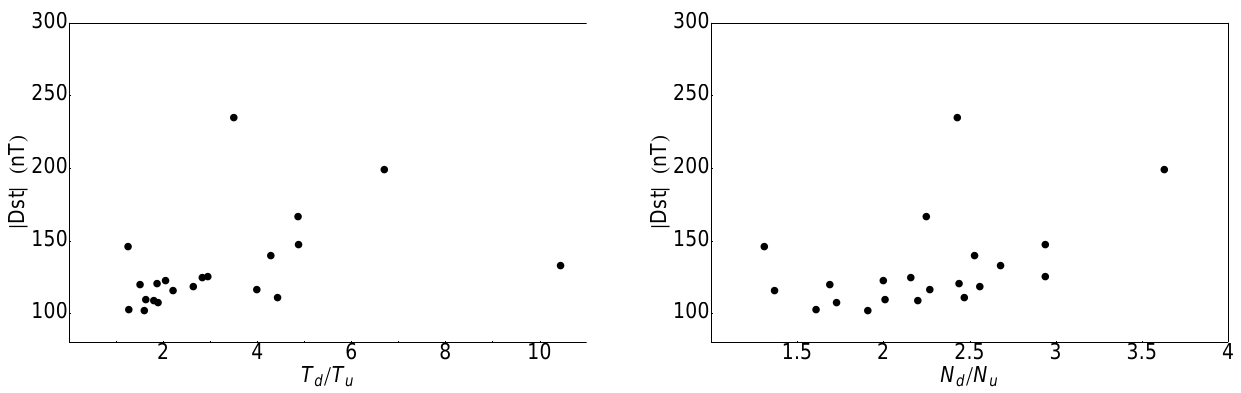
Figure 7. Scatter plots between Dst index and temperature jump ( left ) and density jump ( right ). Table 5. Table of Pearson correlation coefficients between GS Dst index and different parameters of IP phenomena, based on Wind satellite data, unless specified explicitly. The sample size is given in parentheses. IP Parameter Dst-IP